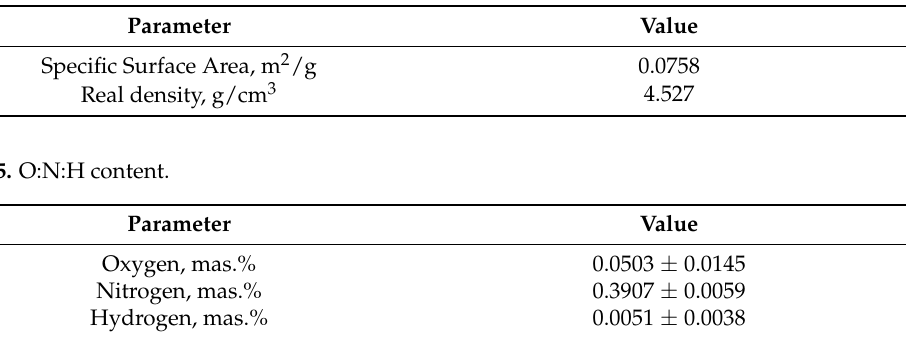
Figure 1. Particle size distribution for Ti 3 AlC 2 powder ( a ) before and ( b ) after sieving. Tables 4 and 5 list the results for density measured by Helium pycnometry and specific surface areas measured by BET, and also the O:H:N content in the feedstock powder. Table 4. BET analysis and Helium pycnometry for Ti 3 AlC 2 powder.